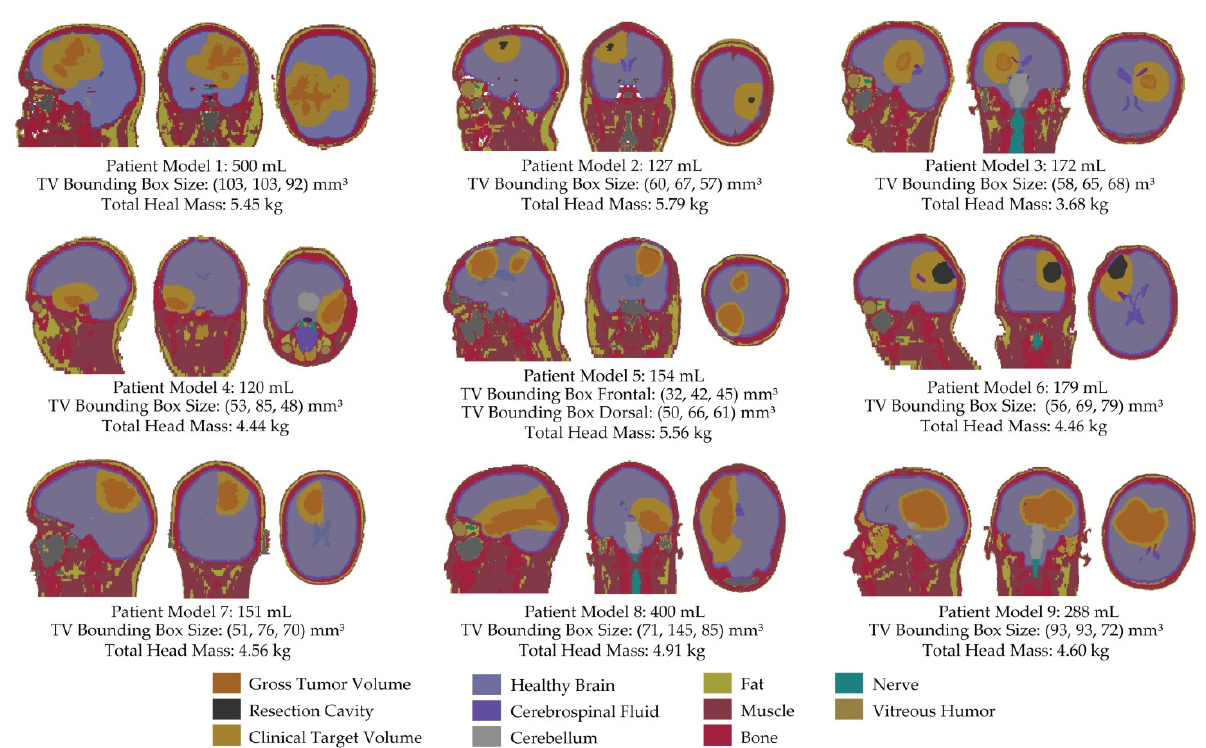
Figure 1. Nine head voxel models were generated based on clinical CT data derived from glioblastoma multiforme (GBM) patients. Each model is depicted in sagittal, coronal, and axial view with the slice positioned at the greatest extent of the target volume. The volume and the bounding box size are indicated for each patient model. The brain was homogeneously modeled (grey) and assigned the resulting dielectric properties (40% white matter + 60% grey matter; σ (avg brain) = 0.52 S/m, ε r (avg brain) = 50.3). The macroscopic tumor mass (dark orange) was assigned σ (tumor) = 1.15 S/m, ε r (tumor) = 66.5 [47]; the resection cavity (black) was assigned dielectric properties of blood ( σ (blood) = 1.32 S/m, ε r (blood) = 65.7); the clinical target volume surrounding the tumor (light orange) was assigned dielectric properties of the brain. The latter together with either the gross tumor volume or the resection cavity form the target volume for patient-specific hyperthermia treatment planning (HTP). In Pat Model 4, the tilting of the head results in the axial slice at the largest extent of the clinical target volume (CTV) to coincide with the CSF surrounding the frontal lobe of the brain. What looks like a seemingly disconnected spot of CSF behind the eyes is in fact a continuous layer to the slice above.